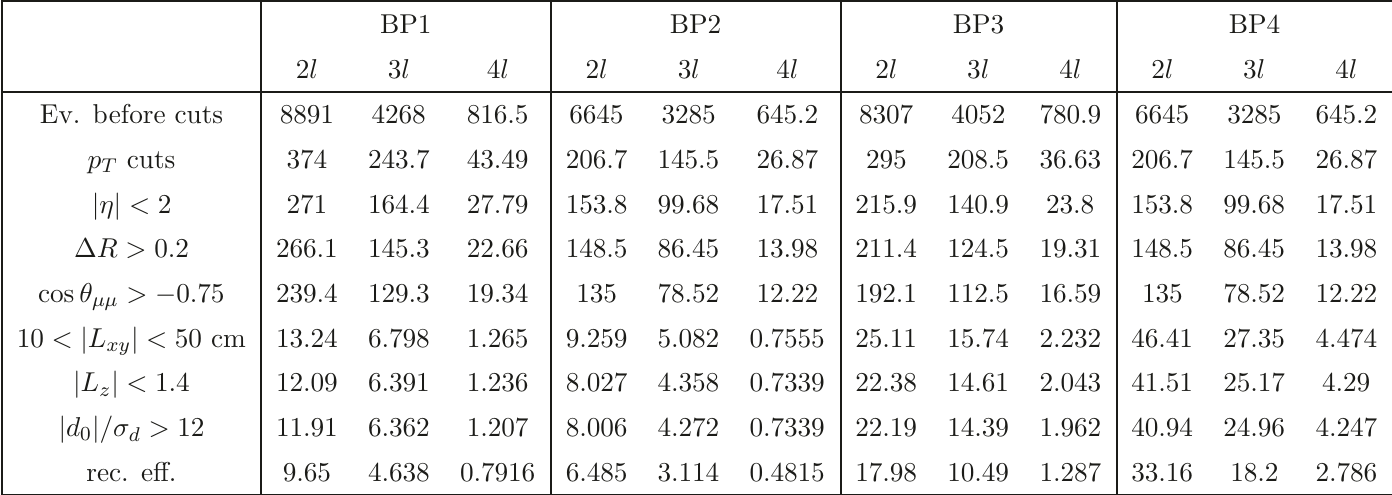
Table 5. Displaced leptons in the inner tracker originated from heavy neutrinos produced by the SM-like Higgs. For each BP the initial number of events generated is the cross section σ ( pp H 1 ν h ν h ) multiplied by a luminosity of 100 fb − 1 . The p T cuts are applied in the following way: p T > → → 26 GeV for the two most energetic leptons and p T > 5 GeV for all the others. The reconstruction efficiency of the leptons has taken into